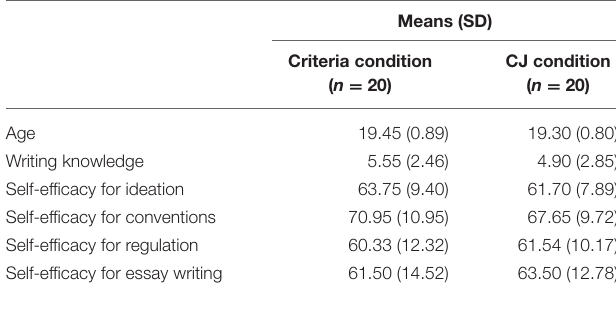
TABLE 3 | Estimates of Logistic Cross-Classified Multilevel Models for Positive Feedback by